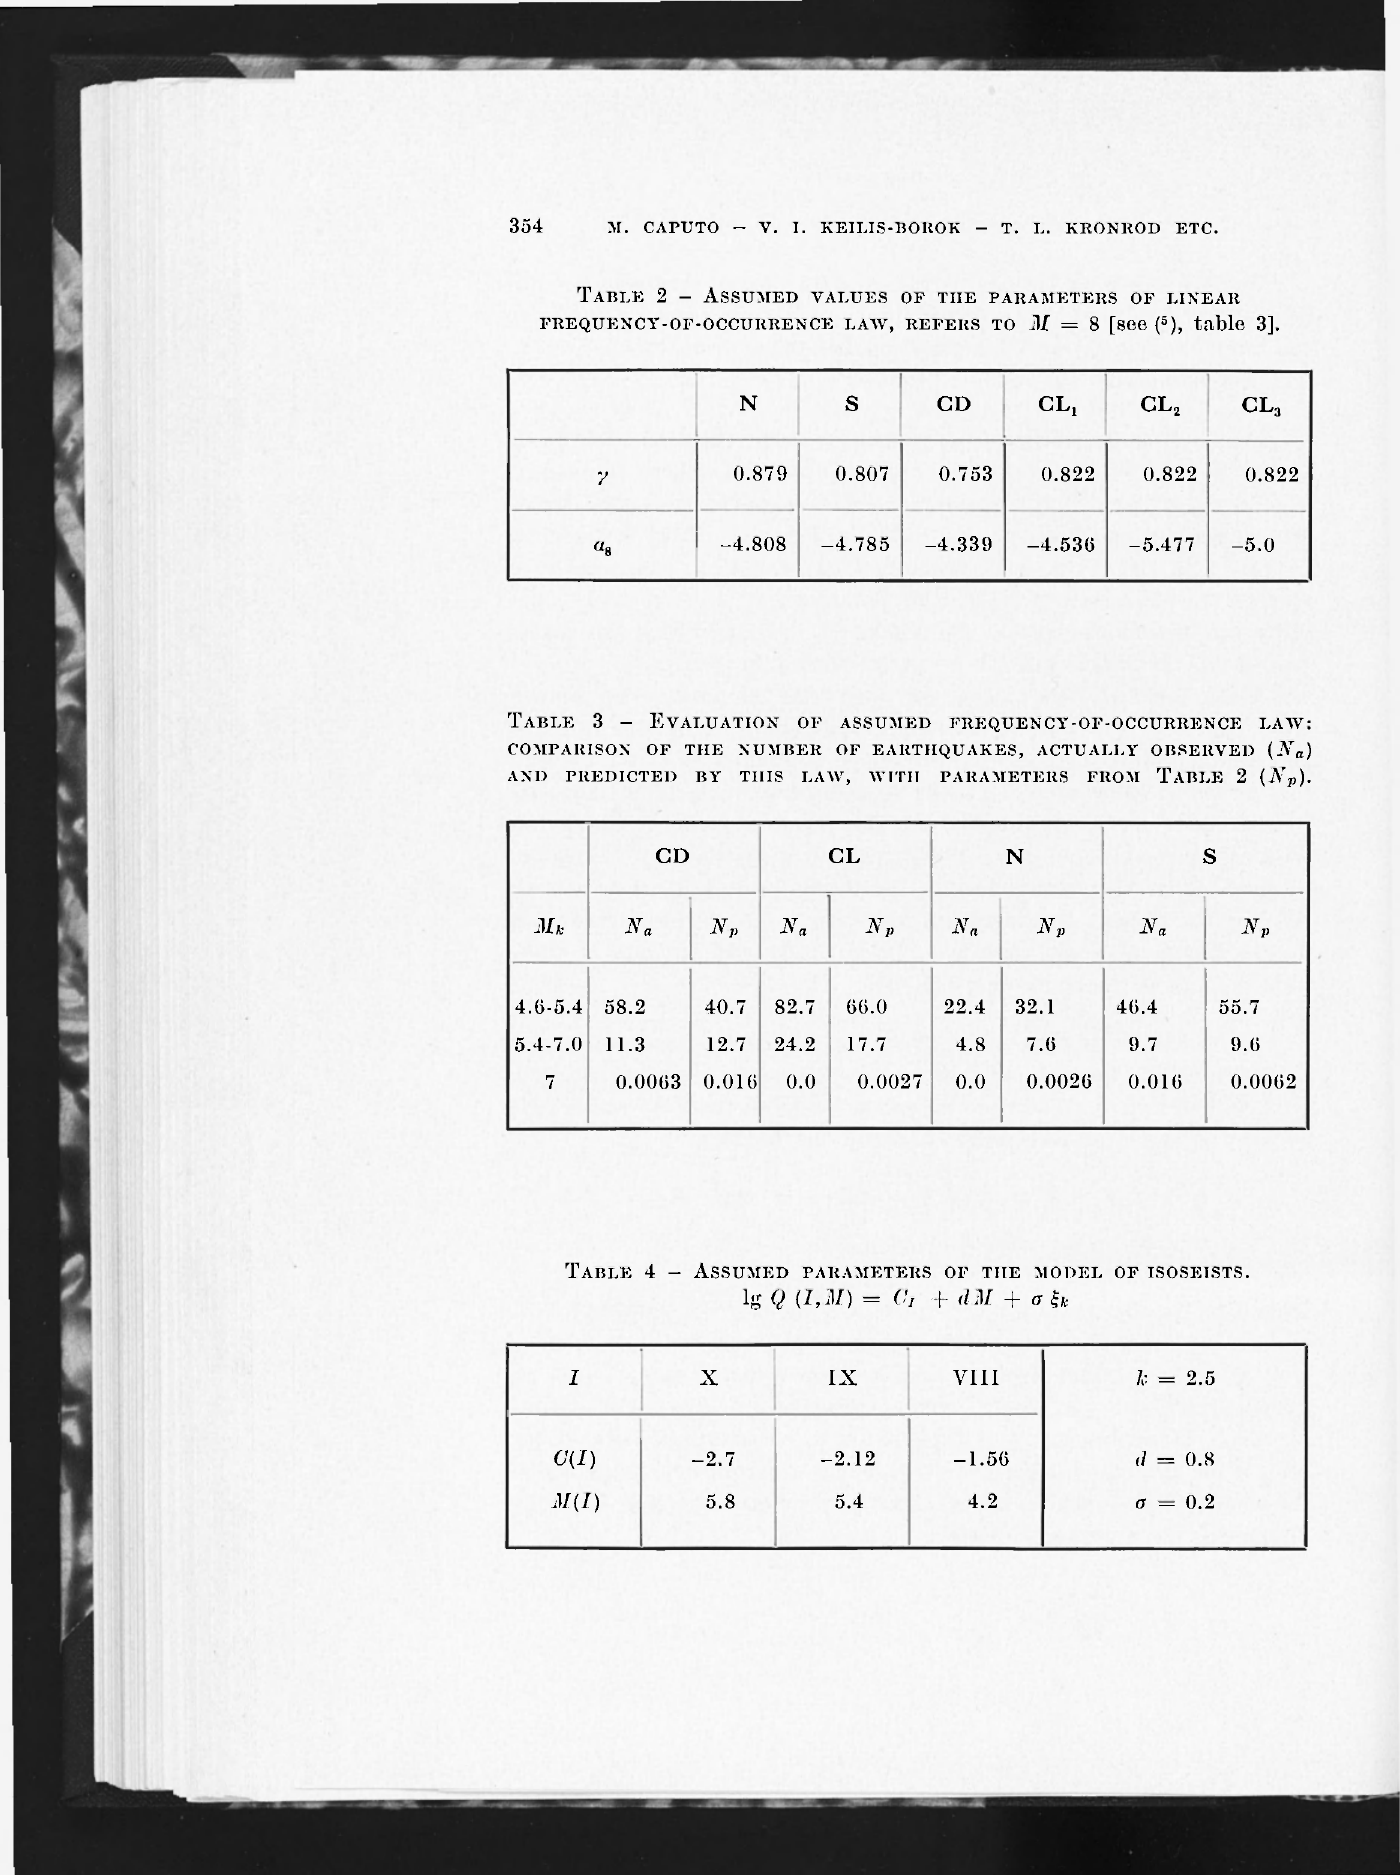
TABLE 2 - ASSUMED VALUES OP TIIE PARAMETERS OP LINEAR